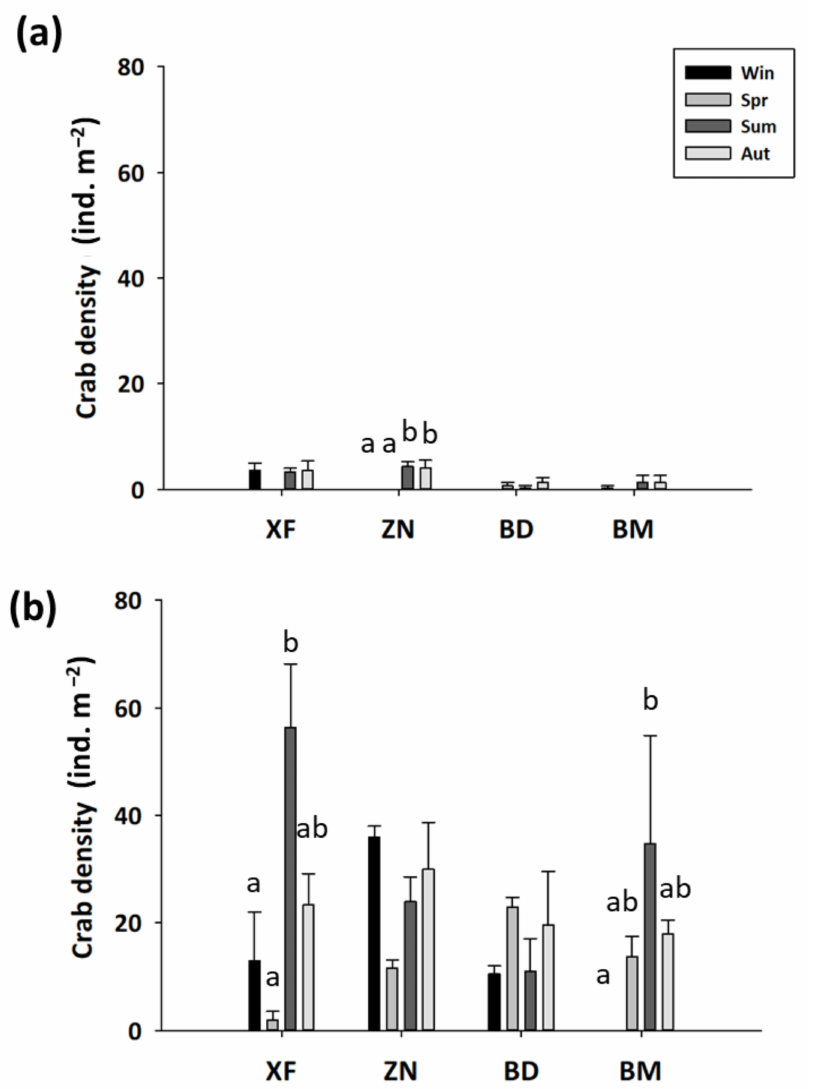
Figure 3. Crab density (mean ± SE) in the ( a ) mangroves and ( b ) nonvegetated mudflats of the four sites on the western coast of Taiwan in different seasons. win, winter; spr, spring; sum, summer; aut, autumn. Within each site, different letters above columns denote significant ( p < 0.05) differences among seasons with the Tukey’s post-hoc